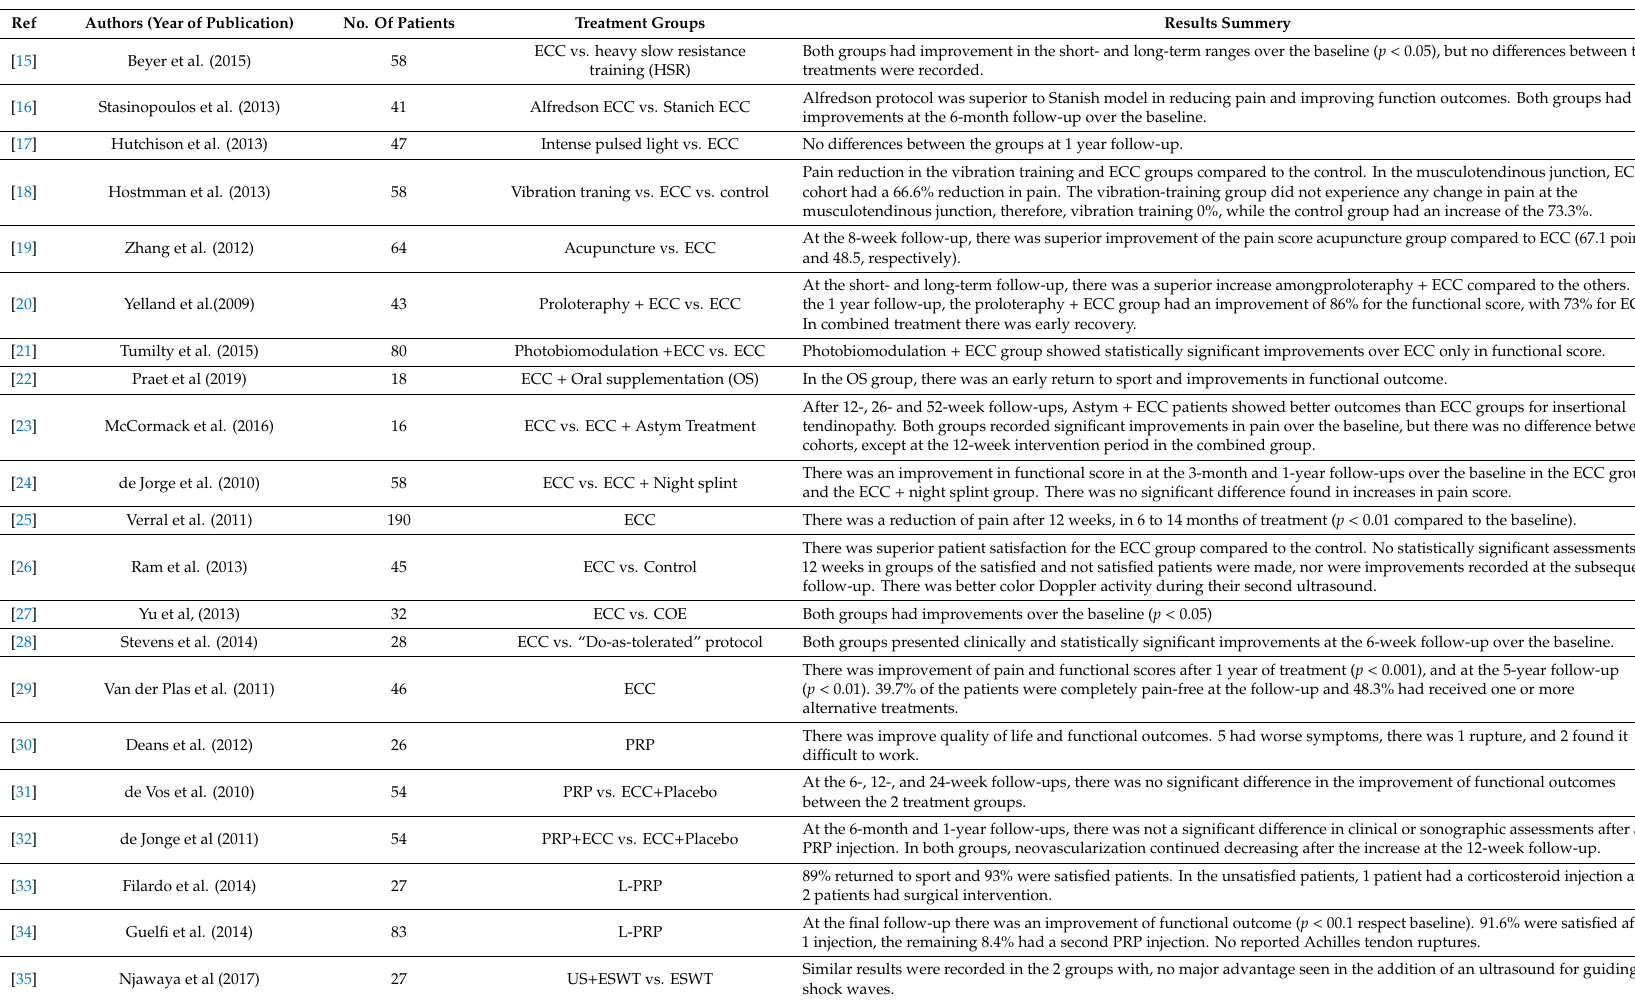
Table 1. The main findings of the studies. ECC = eccentric loading exercise; COE = concentric loading exercise; PRP = platelet rich plasma; L-PRP = leukocyte- and platelet-rich plasma; ESWT = extracorporeal shockwave therapy; ultrasonography = US; GCS = glucocorticoids; HA = hyaluronic